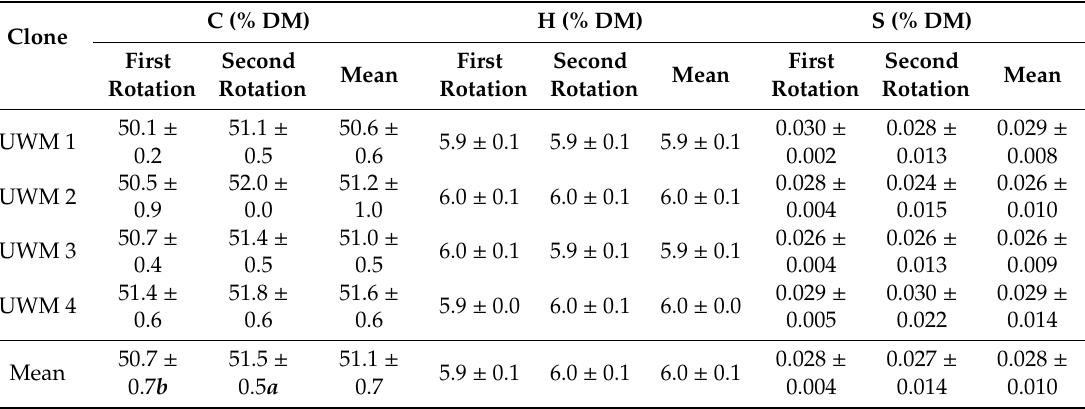
Table 5. Content of carbon (C), hydrogen (H) and sulphur (S) in biomass of four poplar clones in two consecutive 4-year harvest rotations.